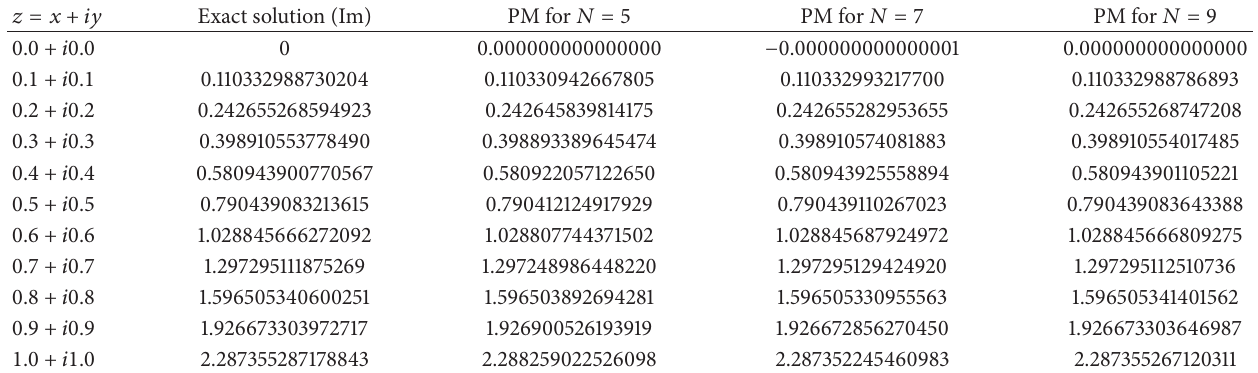
Table 2: Numerical results of Example 13, for Im ( exp (𝑧) = exp (𝑧) sin (𝑦) .